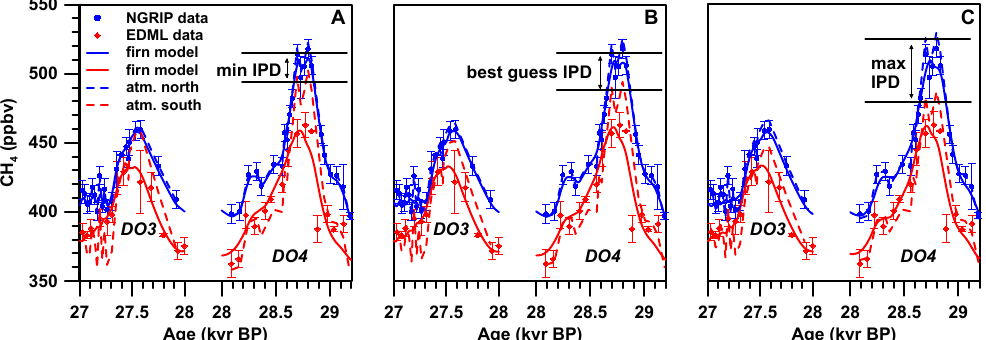
Fig. 4. Firn model applied on DO events 3 and 4. Shown are the NGRIP data (blue circles) and EDML data (red diamonds) corresponding to Fig. 1. Atmospheric signals constructed by linear scaling and shifting the NGRIP data are shown as dotted lines. The corresponding firn model output is shown in blue for NGRIP and in red for EDML. (A) Minimum IPD: minimum attenuation at NGRIP, maximum attenuation at EDML. (B) Mean IPD: mean attenuation at NGRIP, mean attenuation at EDML. (C) Maximum IPD: maximum attenuation at NGRIP, minimum attenuation at